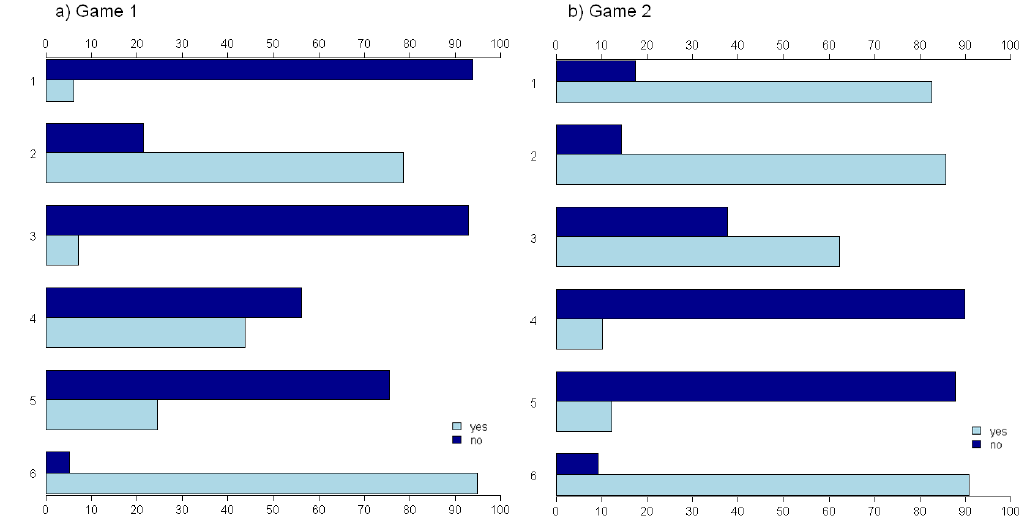
Fig. 3. Frequencies (in %) of “yes” (decision to open the gate) and “no” (decision to not open the gate) answers for Game 1 (left panel) and Game 2 (right panel), and for all six cases (see Table 1). Cases 5 and 6 are associated with a flood occurrence. The order of presentation of the cases during the games was: Game 1=[1, 2, 3, 4, 5, 6]; Game 2=[5, 1, 4, 3, 6, Figure 3. Frequencies (in %) of ‘yes’ (decision to open the gate) and ‘no’ (decision to not 3 open the gate) answers for Game 1 (left) and Game 2 (right), and for all six cases (see 4 Table 1). Cases 5 and 6 are associated with a flood occurrence. The order of 5 presentation of the cases during the games was: Game 1 = [1, 2, 3, 4, 5, 6]; Game 2 = [5, 6 1, 4, 3, 6, 2,]. 7